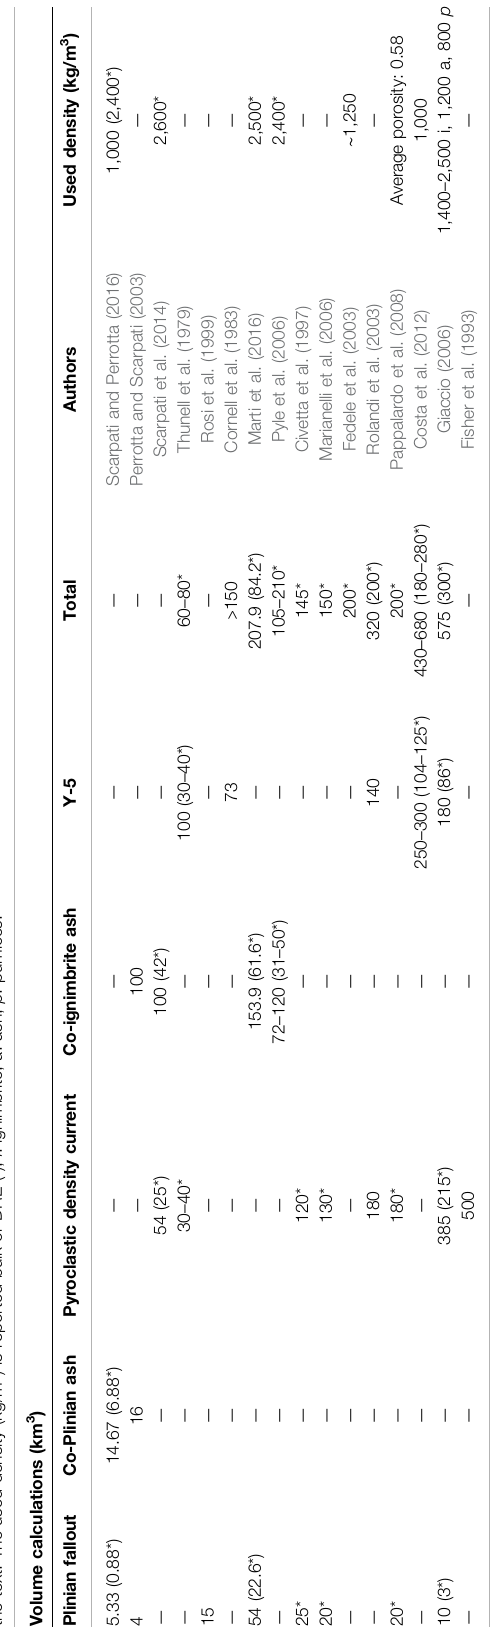
(except for the Lago di Patria outcrop, Supplementary Table S2 ), data shows little evidence of lateral unit change. In our study, we refer to the stratigraphic units proposed by Fedele et al. (2008) (proximal area) and Cappelletti et al. (2003) (distal areas) ( Online Supplementary Material ). The fi rst fl ow unit is the Unconsolidated Strati fi ed Ash Flow (USAF) both in proximal and distal stratigraphy, which is followed by the main units of Piperno and Breccia Museo inside the caldera and the Welded Gray Ignimbrite (WGI) and Lithi fi ed Yellow Tuff (LYT) in medial and distal